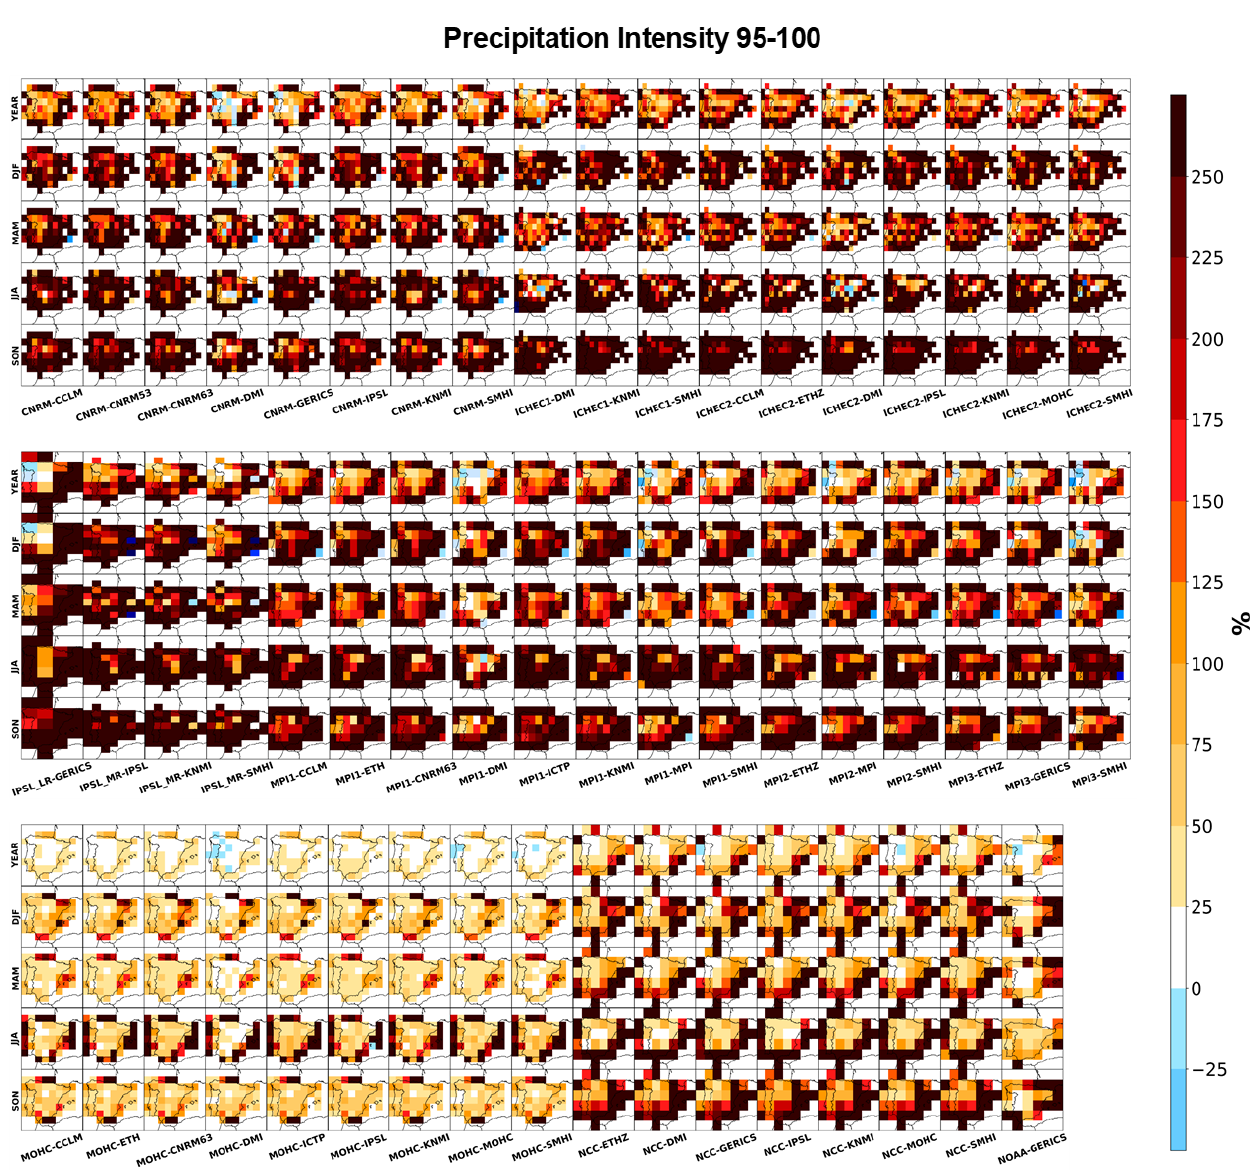
Figure 7. Yearly and seasonal distribution added values (DAVs) of the Iberian Peninsula for the historical (1971–2005) EURO-CORDEX RCMs, with the IGD as a reference for the daily precipitation intensity, only considering the values above the observational 95th percentile. All RCM data were previously interpolated to 0.1 ◦ regular resolution from the observations, while the observations were interpolated into each CMI5 GCM